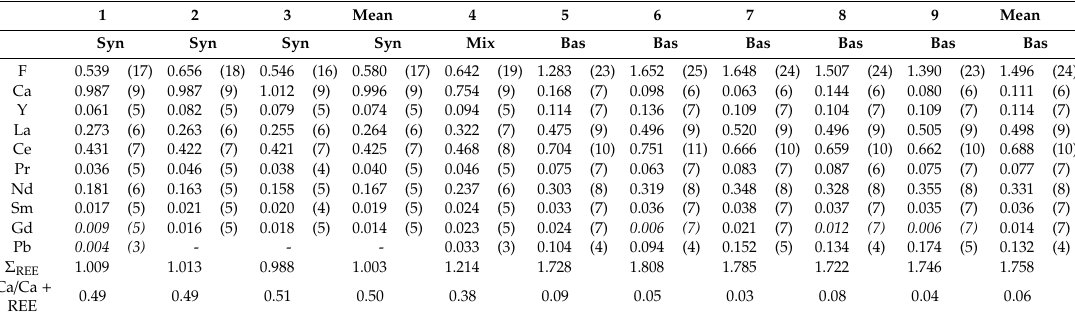
Table 2. Composition of (Ca,REE)-Fluorcarbonates from Cinquevalli (Trento, Italy). Atoms Calculated on the Basis of Two Cations in the Chemical Formula. Relative Error in Brackets (Values in Italics when Below 2σ).